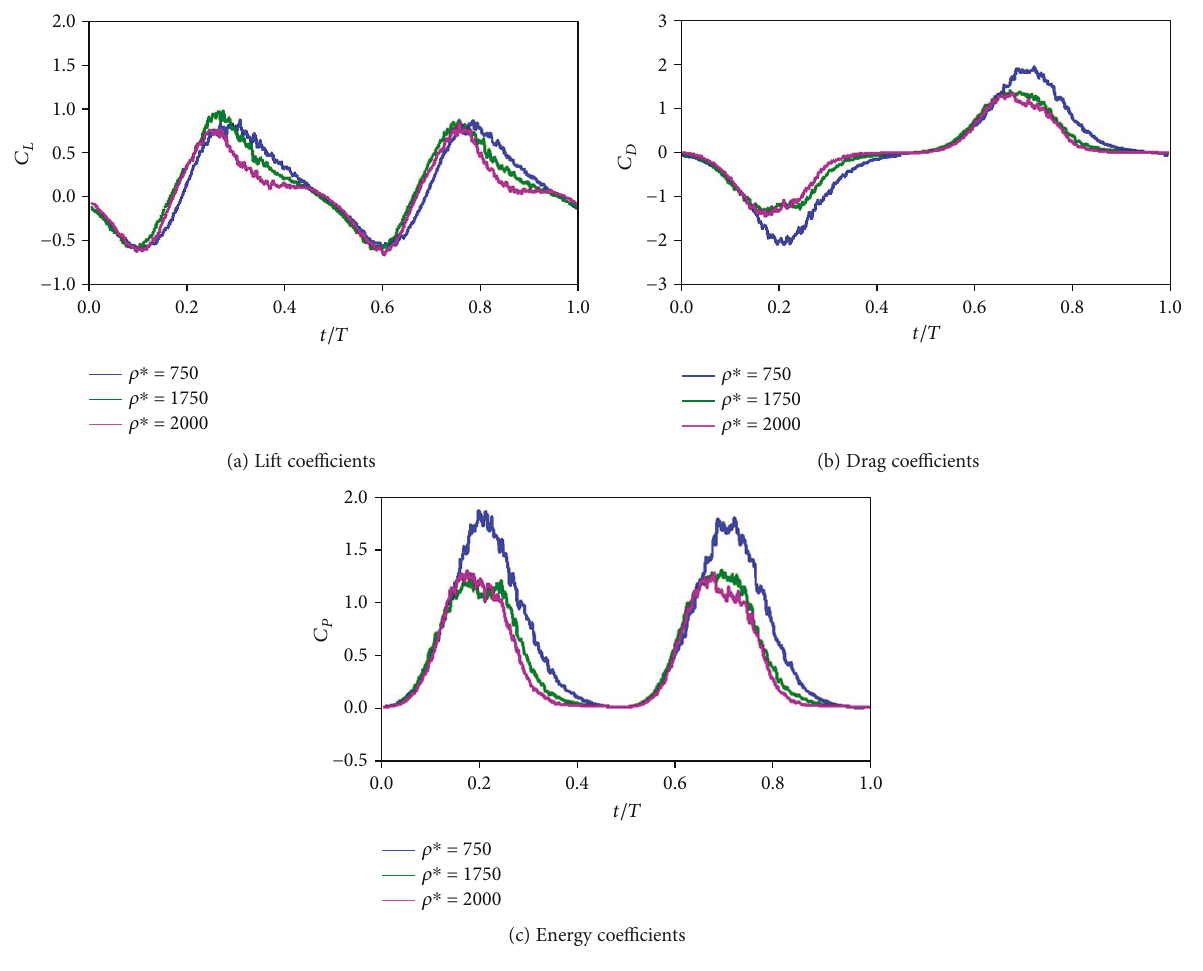
Figure 13: Time variation of the lift coe ffi cients, drag coe ffi cients, and energy coe ffi cients of the 3D lumped fl exibility wing with ρ ∗ = 750 , 1750, and 2000.